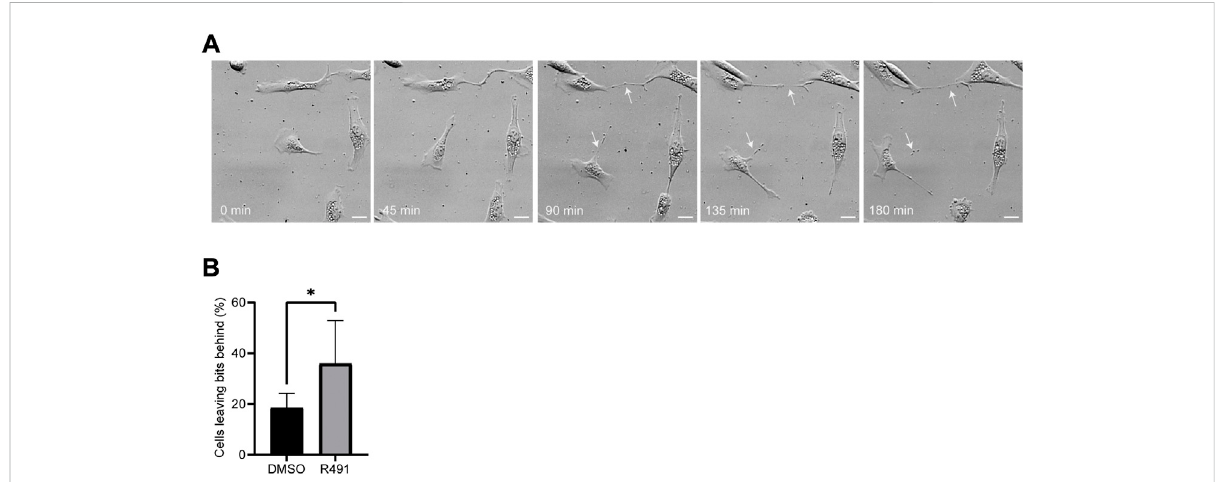
FIGURE 6 R491 forms long thin extensions at the training edge in BJ-Ras cells that often detach during cell migration. (A) Montage of 5 sequential images ofrepresentativeR491-treated cells. Whitearrowsindicate theretraction fi bersthat remain behindthecell,and oftenbreak off,duringmigration. (B) Fraction of cells from which debris is detached without and with R491-treatment, as indicated. Data presented as mean ± SD. ** p ≤ 0.01. Scale bars: 50 μ